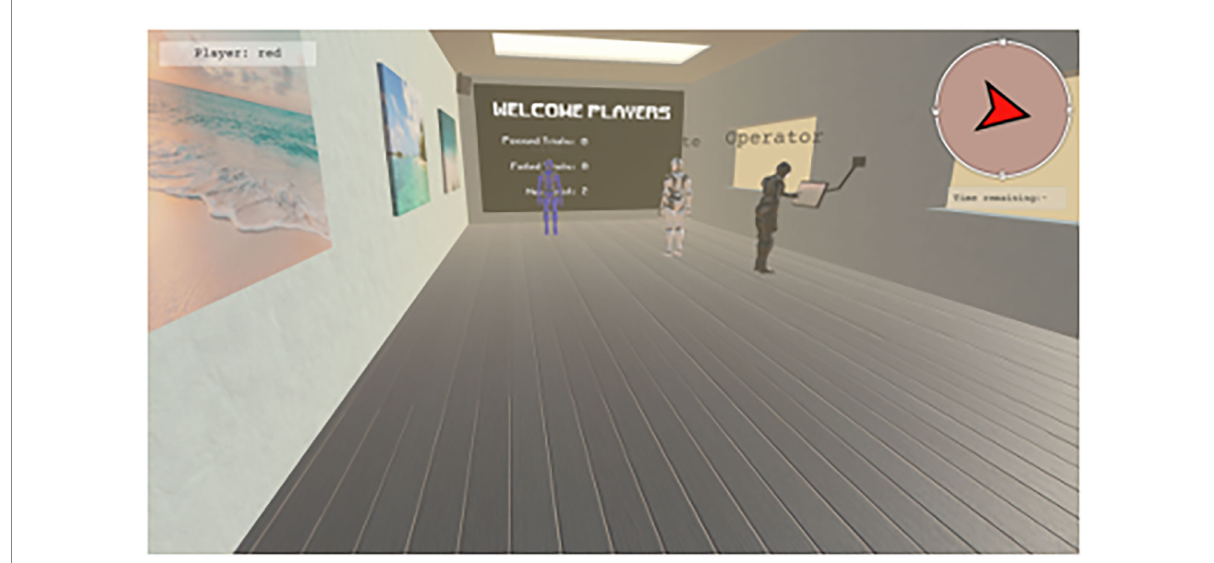
FIGURE 3 View of the game lobby. Participants were embodied as humanoid avatars, whose color was the same as the participant’s name in the experiment (the participant playing as the drone operator was referred to as “Operator”). Following each trial, participants were teleported to a game lobby where participants received feedback regarding the previous trial, summary of how many trials were successful/unsuccessful, and a timer to indicate when the next trial was to